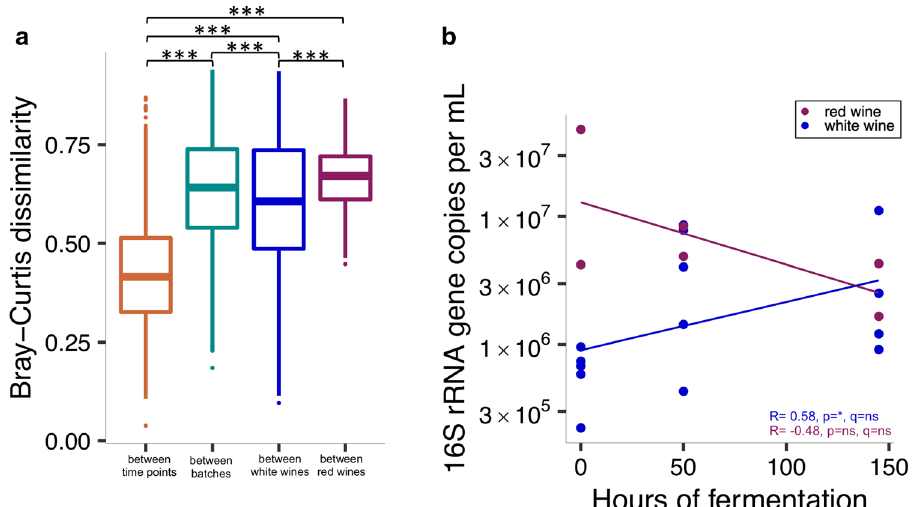
Figure 4. Bacterial microbiota changes during fermentation. Taxonomic microbiota compositions were compared between samples, based on Bray–Curtis dissimilarity, showing that samples from the same wine were more similar to each other and that red wine samples were more heterogeneous than white wine samples ( a ). Bacterial abundances of red and white wines showed opposing trends during fermentation, based on 16S rRNA gene copy numbers ( b ). Significance was calculated based on Wilcoxon rank-sum test ( a ) and Spearman’s rank correlation test ( b ), all corrected with the Benjamini–Hochberg procedure, with ns = not significant, *p/q < 0.05, ***p/q <